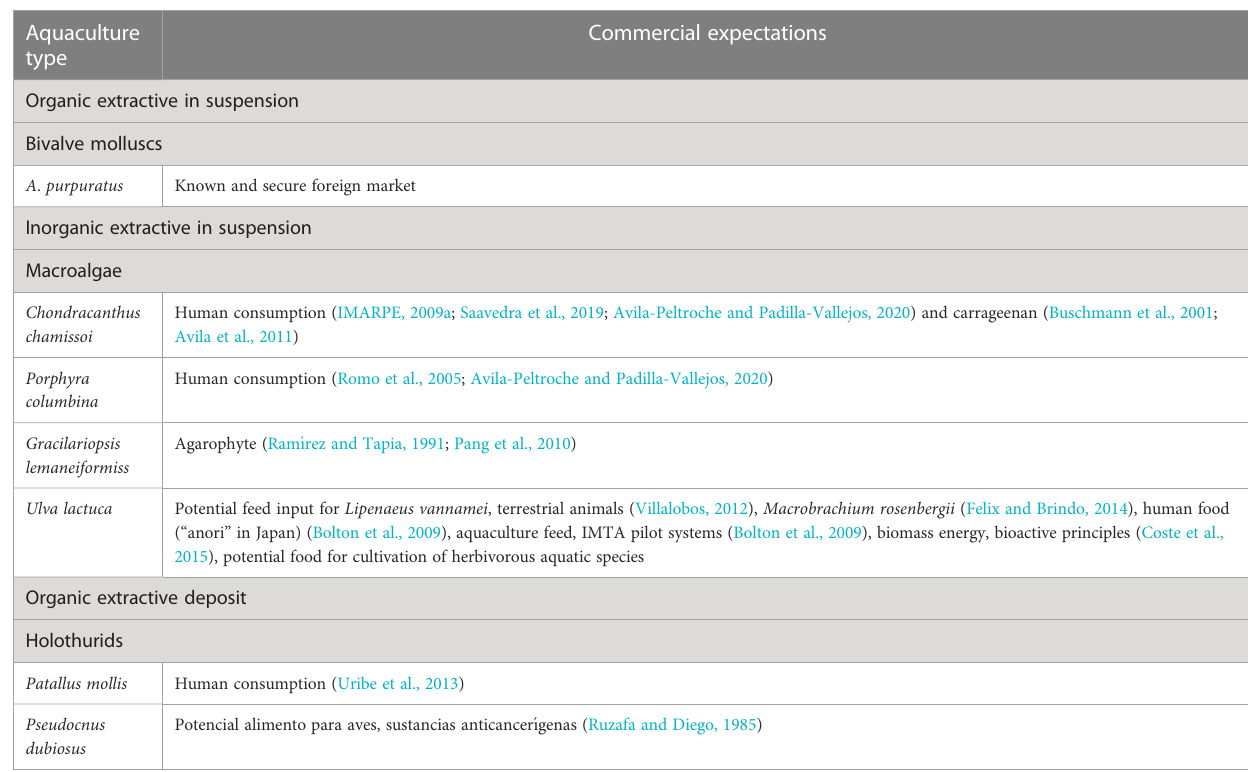
TABLE 4 Components of the IMTA and local candidate species for cultivation in Samanco